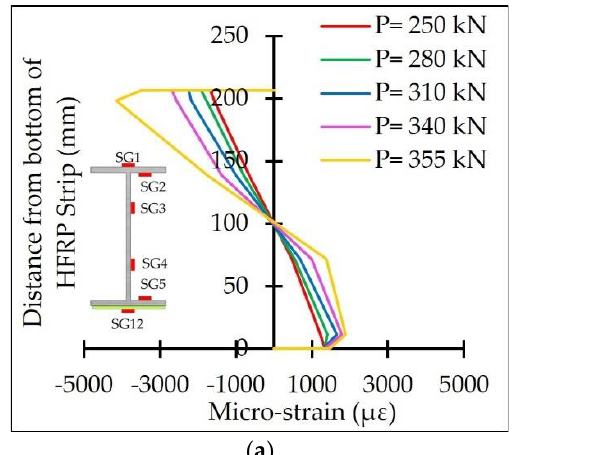
(SG17) were mirrored around the beam centerline for a more meaningful